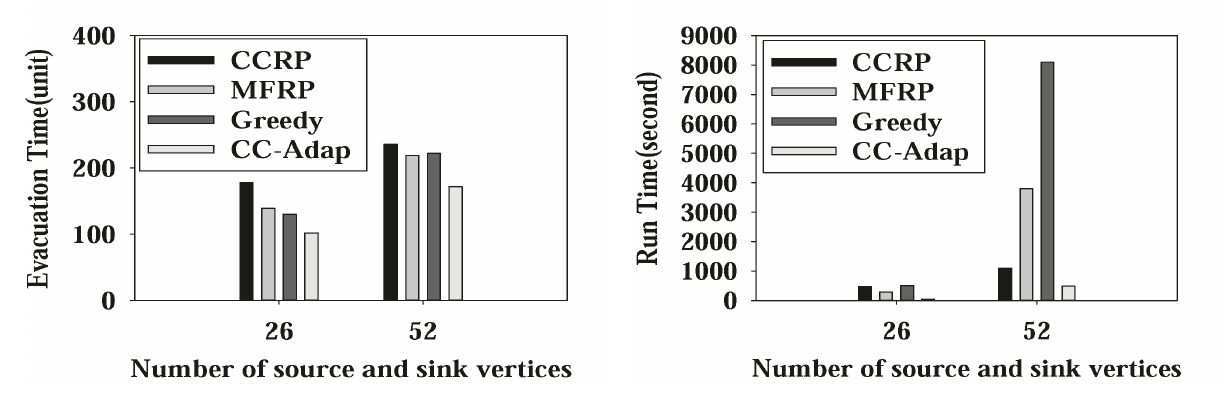
Figure 8: Evacuation quality with respect to the number of source and sink vertices.